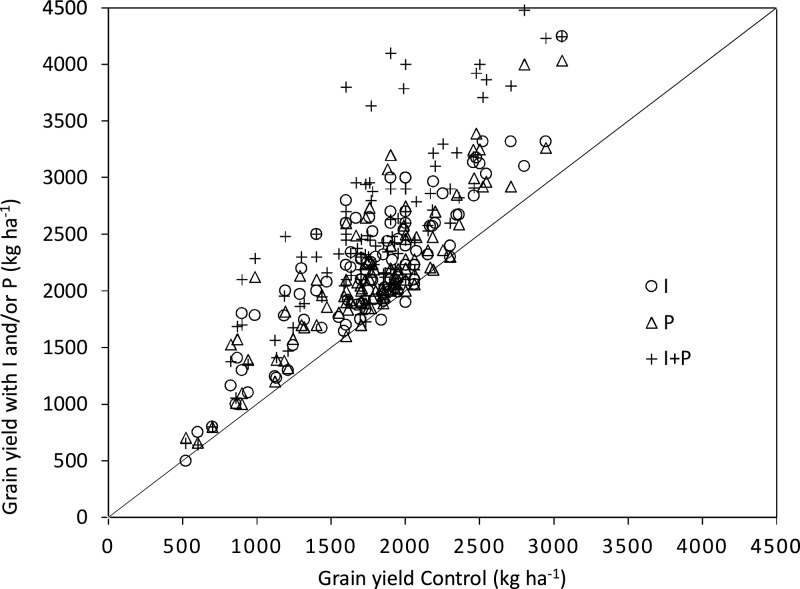
Chickpea grain yields control (kg ha−1) and response to P, I and P + I for individual farms in the target Woredas in Ethiopia (2012–2015). P = 23 kg P2O5 ha−1applied as TSP or DAP fertilizer; I = seed inoculated with Mesorhizobium.